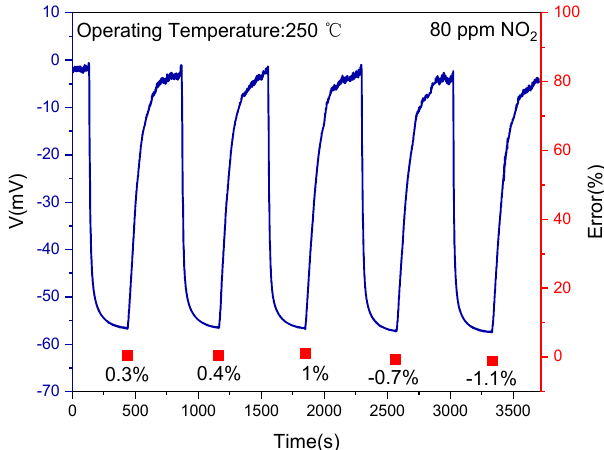
Figure 8. Continuous five times response–recovery transient characteristics of Sensor C to 80 ppm NO 2 at 250 °C.